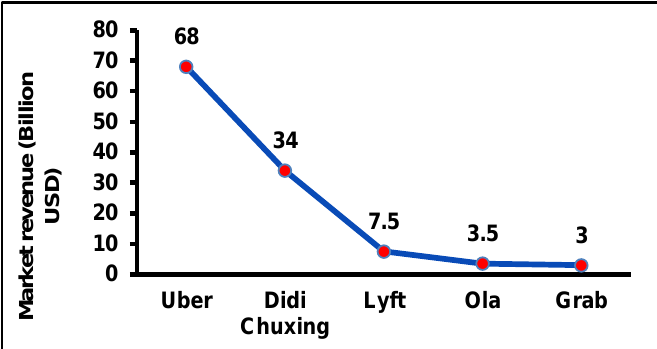
Fig. 1. Market revenue captured by the globally renowned ride-sharing